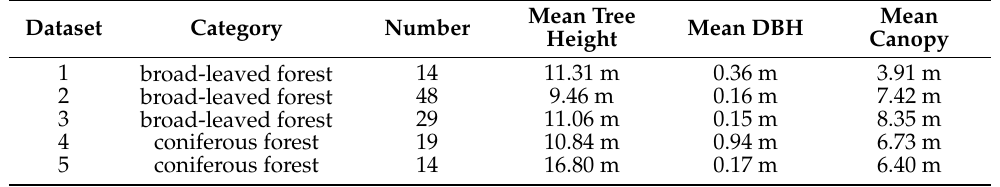
Table 2. Street tree information in 5 datasets.